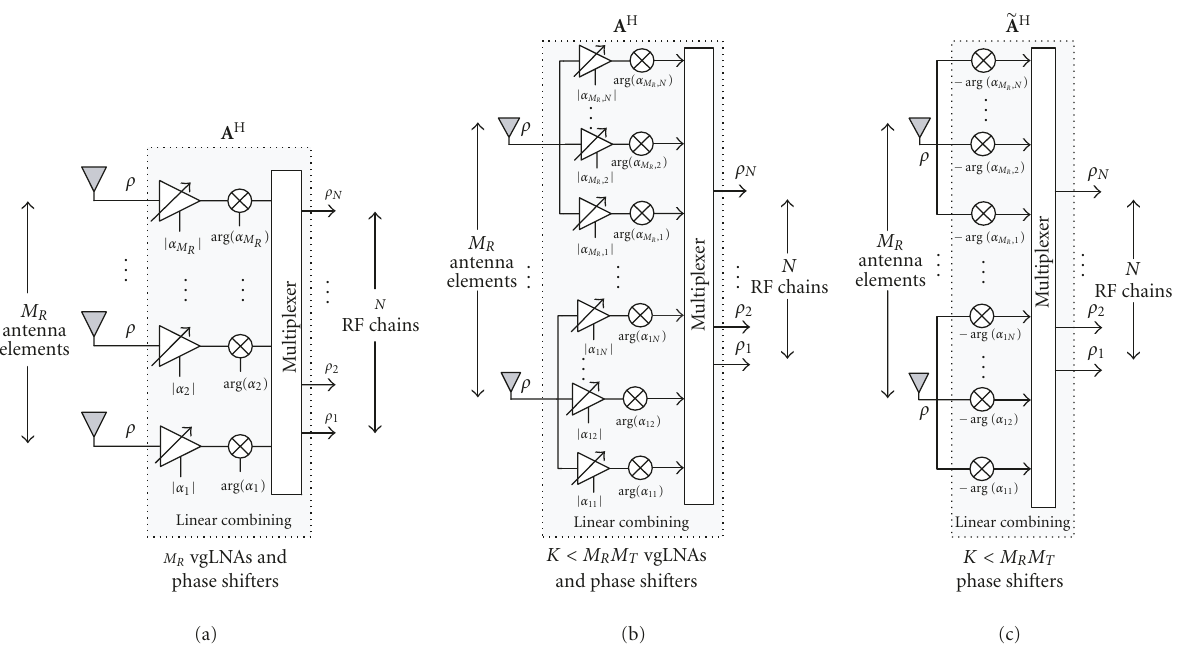
Figure 2: Receiver structures for several receive antenna subarray formation (ASF) schemes: (a) strictly-structured ASF (SS-ASF), (b) relaxed-structured ASF (RS-ASF) and (c) reduced hardware complexity ASF